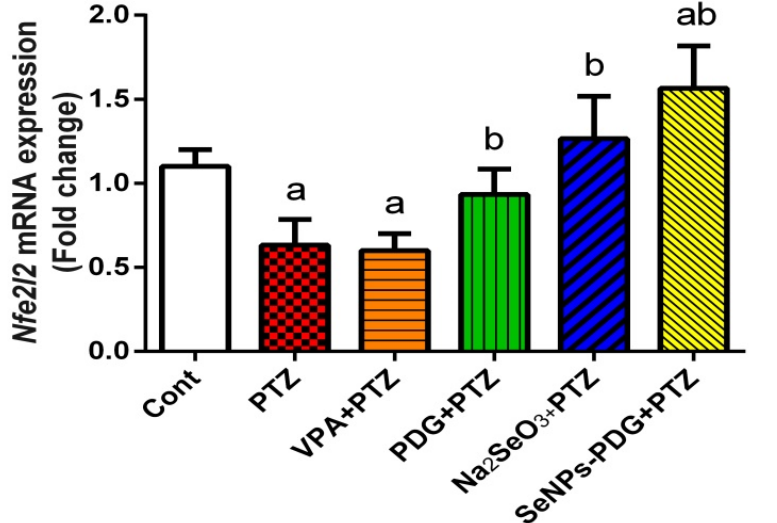
Figure 2. Effects of orally administered prodigiosin (PDG), sodium selenite (Na 2 SeO 3 ), and green biosynthesized SeNPs with PDG (SeNPs-PDG) on the mRNA expression levels of Nrf2 in hippocampal tissue following pentylenetetrazole (PTZ)-induced epileptic seizures. a and b denote significant differences ( p < 0.05) compared with the untreated control and PTZ-injected groups, respectively. All records are presented as the mean ± standard deviation (SD).